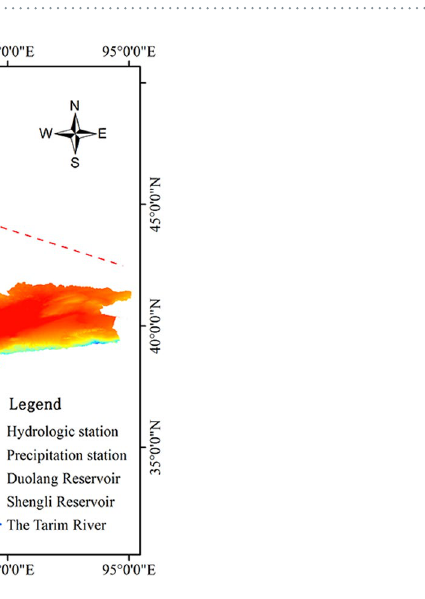
Figure 7. Temporal trend in annual precipitation at the upper reach of the Tarim River over 55 years (dash line is the linear fitting for the annual precipitation over 55 years with a slope of 0.71).